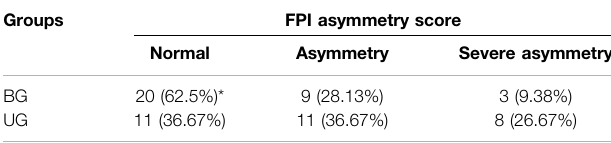
TABLE 2 | Comparison of FPI asymmetry score between two